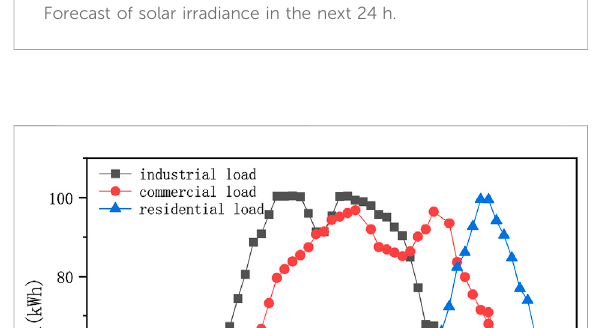
FIGURE 4 Forecast of solar irradiance in the next 24 h.